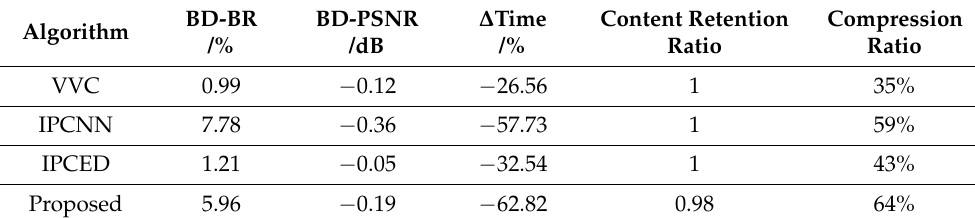
Table 6. Comparison of video compression performance between algorithms in this paper, reference algorithms, and VVC